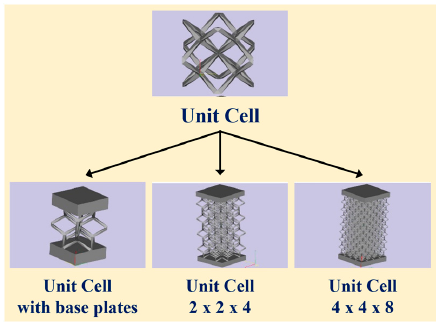
Figure 2. Schematic of the selective laser melted 316L steel cellular dodecahedron structures (only one relative density is shown).